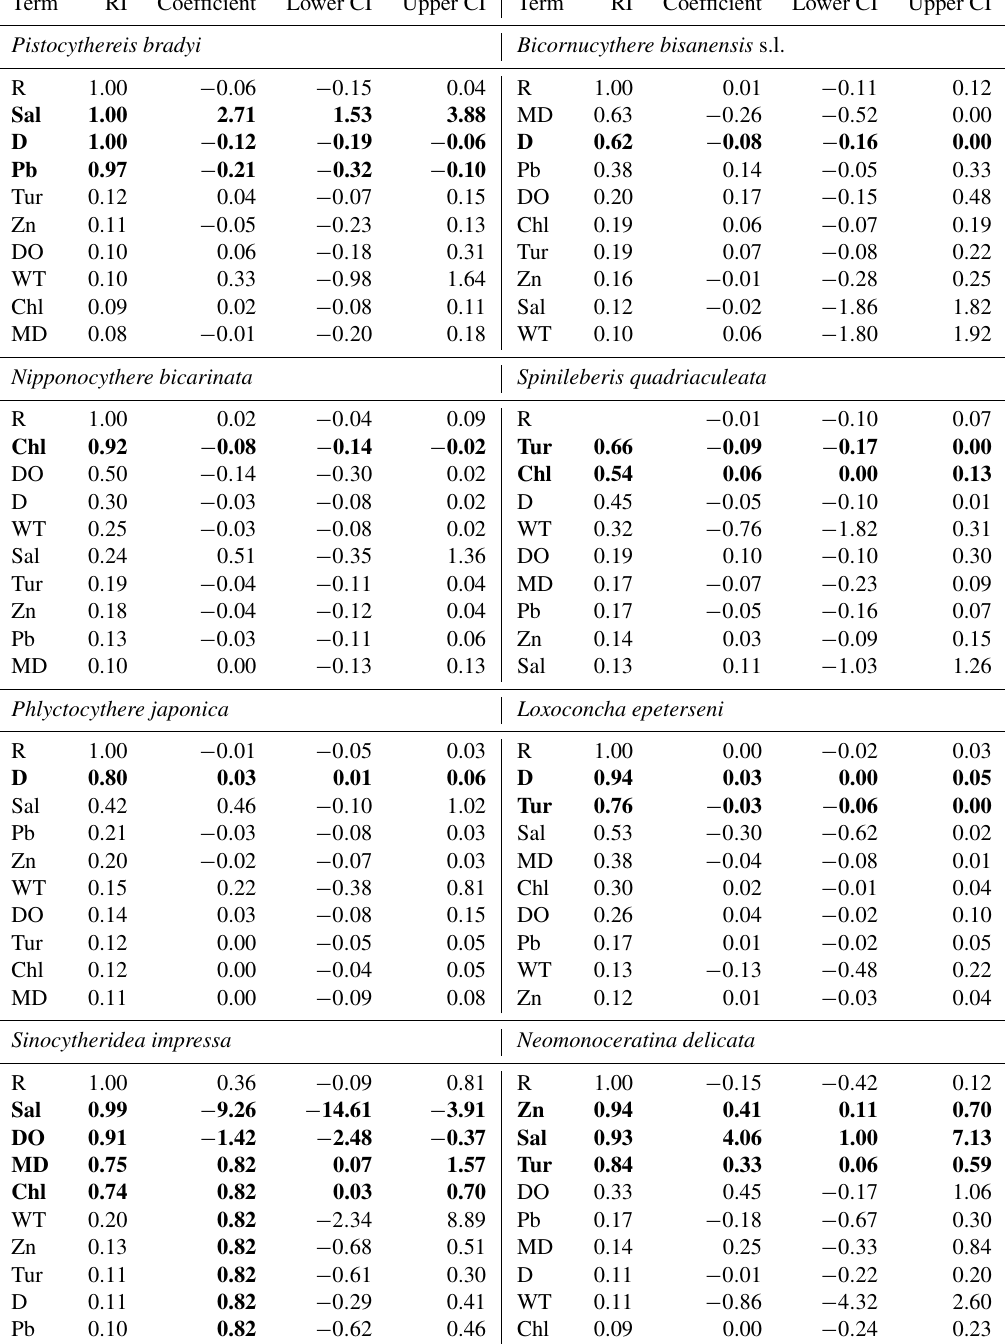
Table 3. Model-averaged parameter estimates and CIs of the relative abundance for common species including Pistocythereis bradyi , Bicornucythere bisanensis s.l., Nipponocythere bicarinata , Spinileberis quadriaculeata , Phlyctocythere japonica , Loxoconcha epeterseni , Sinocytheridea impressa , Neomonoceratina delicata , Keijella kloempritensis , Neosinocythere elongata , Stigmatocythere roesmani , Hemi- cytheridea reticulata Loxoconcha malayensis , Alocopocythere goujoni , Hemikrithe orientalis , Propontocypris spp., Neonesidea spp., and Xestoleberis spp. CIs, confidence intervals; RI, relative importance (the sum of the Akaike weights of models that include the variable in question; see Materials and Methods); R, region. Other abbreviations are found in Table 1. Bold denotes CIs that exclude zero. For R, coefficient, lower CI, and upper CI values shown are averages of those for geographic